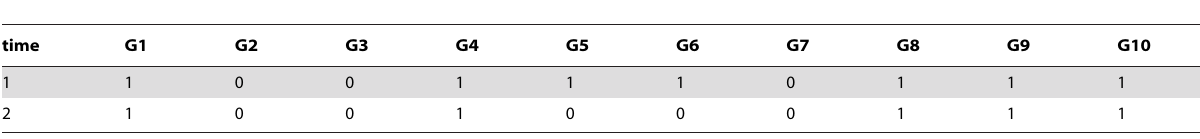
Table 11. Third time trajectory after discretization (t =500 to t